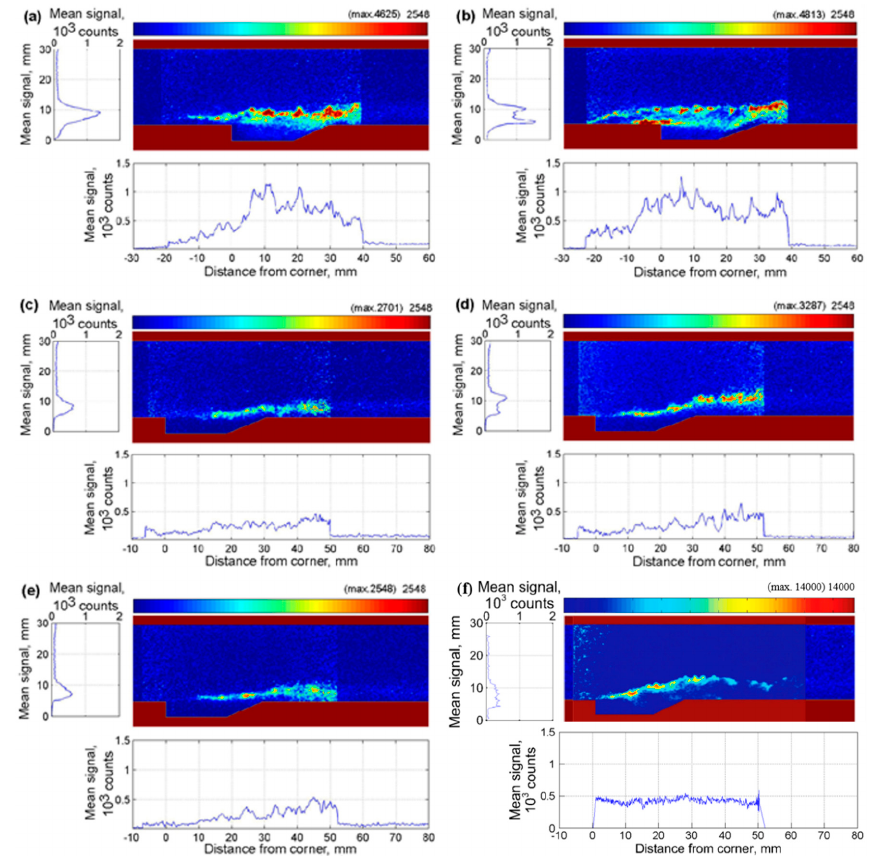
Figure 2. OH-PLIF (planar laser-induced fluorescence) images near the cavity for the h 0 = 6.45 MJ / kg air flow condition: ( a ) angled injection, Φ = 0.13; ( b ) angled injection, Φ = 0.44; ( c ) parallel injection, Φ = 0.13; ( d ) parallel injection, Φ = 0.44; ( e ) upstream injection, Φ = 0.13; ( f ) upstream injection, Φ = 0.47; h 0 = 6.28 MJ / kg